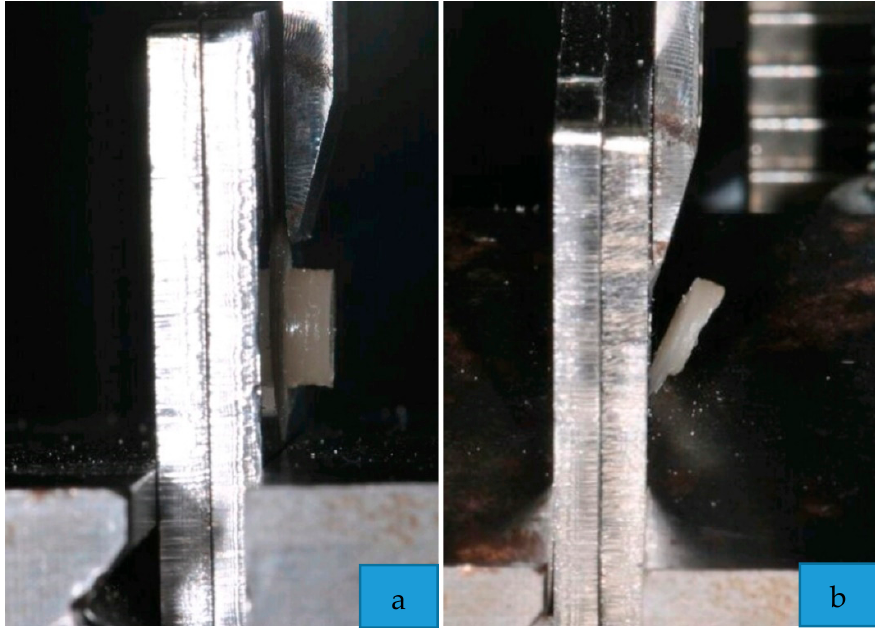
Figure 3. Phases of the shear bond strength testing: ( a ) application of the force; ( b ) failure of the cement.